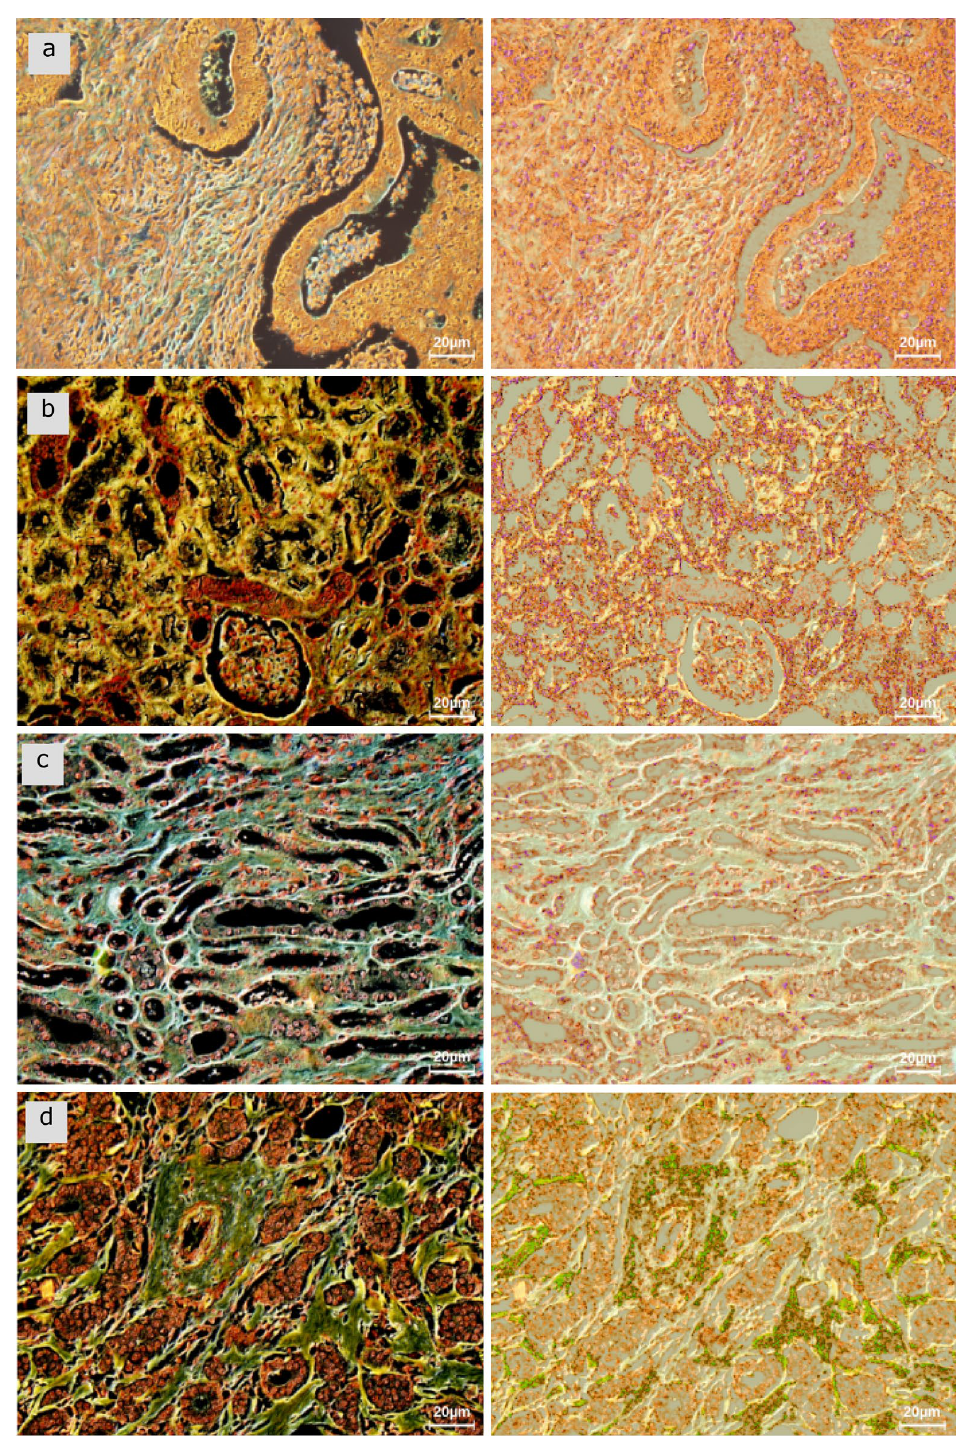
Figure 6. At the left, four digital images acquired by means of a MUSE microscope of Hoechst and rhodamine- stained 5-µm sections, and at the right, same images superimposed with the images processed by the high frequency technique: ( a ) slice of colorectal cancer tissue, ( b ) slice of renal medulla (normal), ( c ) slice of renal cortex (normal), ( d ) slice of breast cancer